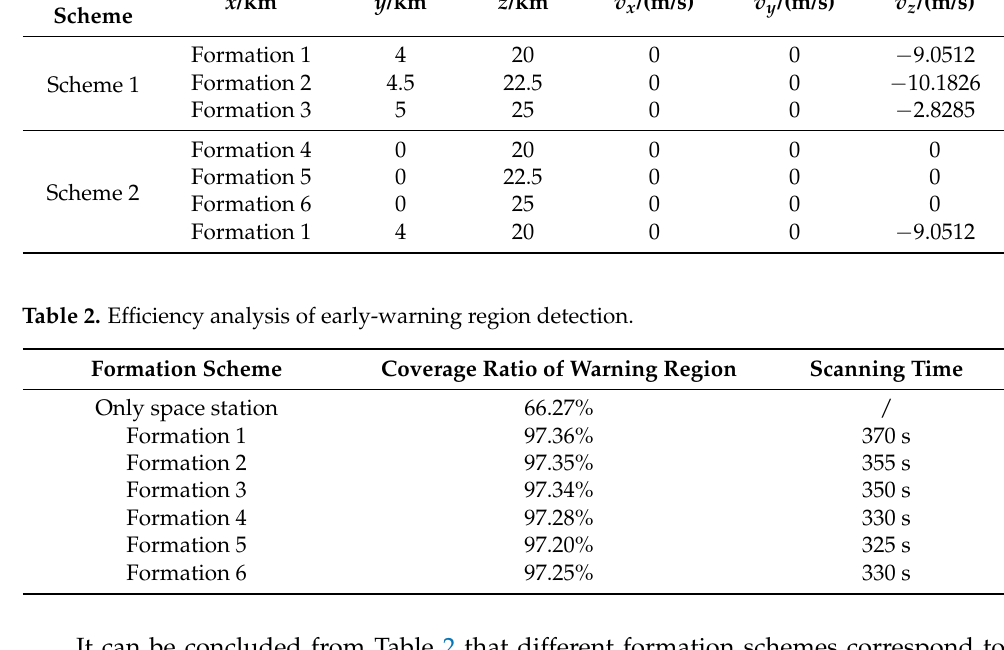
Figure 9. Region covered only by the scanning of the space station: ( a ) Early-warning region on YOX plane of the space station’s orbital coordinate system; ( b ) early-warning region on YOZ plane of the space station’s orbital coordinate system.